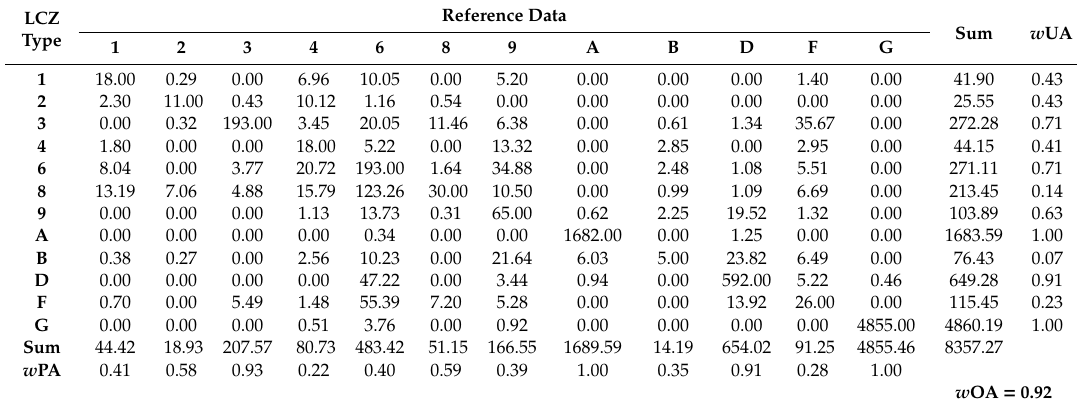
Table 3. Weighted error matrix generated using our synthetic dataset with 12 LCZ classes. LCZ